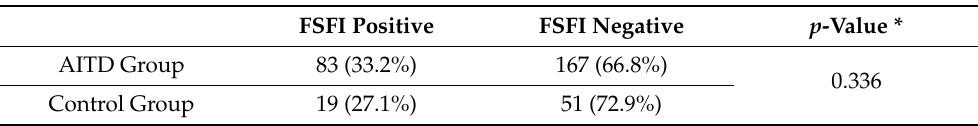
Figure 1. Kruskal–Wallis Test. Table 4. The distribution of patients (%) with positive diagnosis of female sexual dysfunction according to the FSFI scale (score ≤ 26.55).